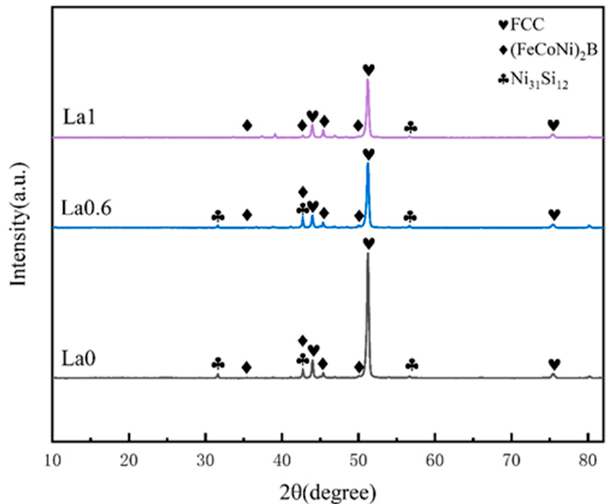
Figure 1. The XRD pattern of as ‐ cast Fe 27 Co 27 Ni 27 Si 10 − x B 9 La x (x = 0, 0.6, 1) ingots.